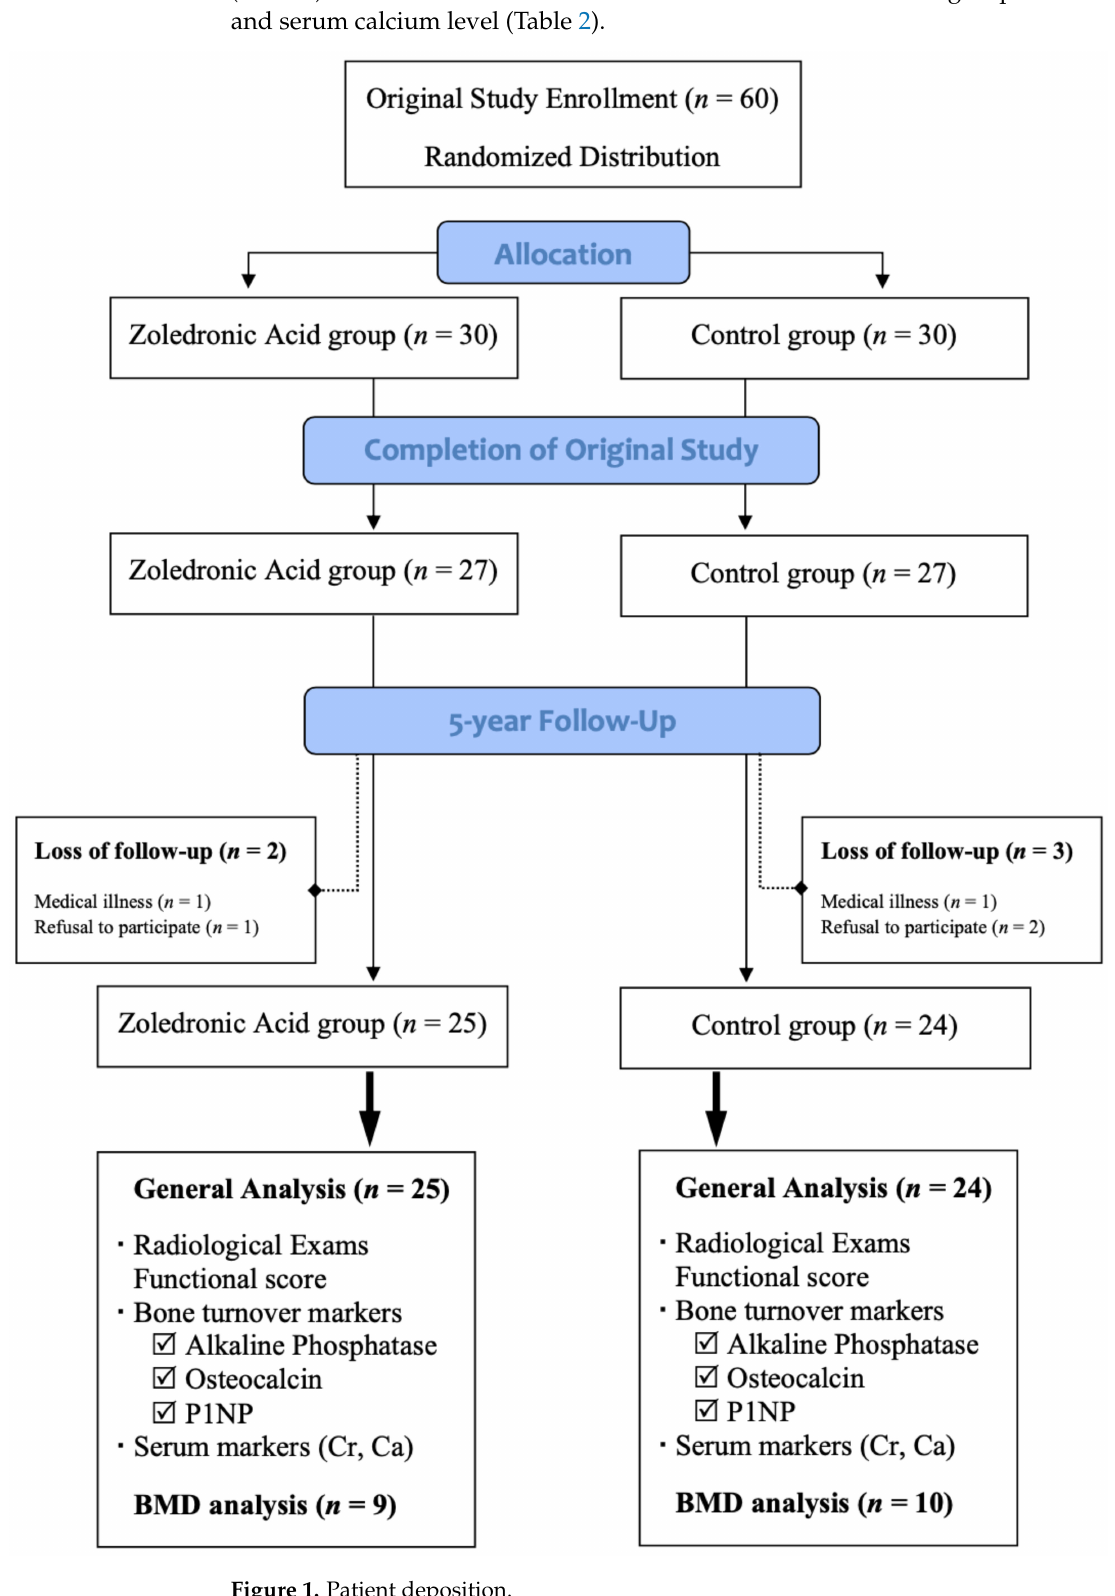
Figure 1. Patient